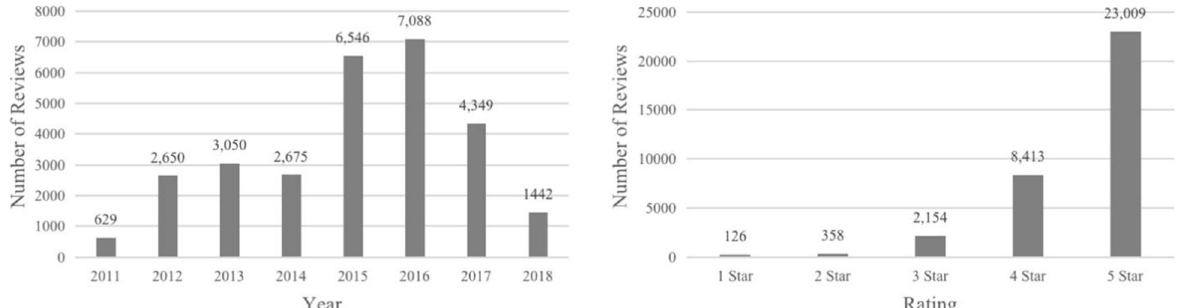
Fig. 2 Yearly reviews numbers (left) and rating distribution (right) of The High Line (reviews for both 2011 and 2018 are counted for only half of a